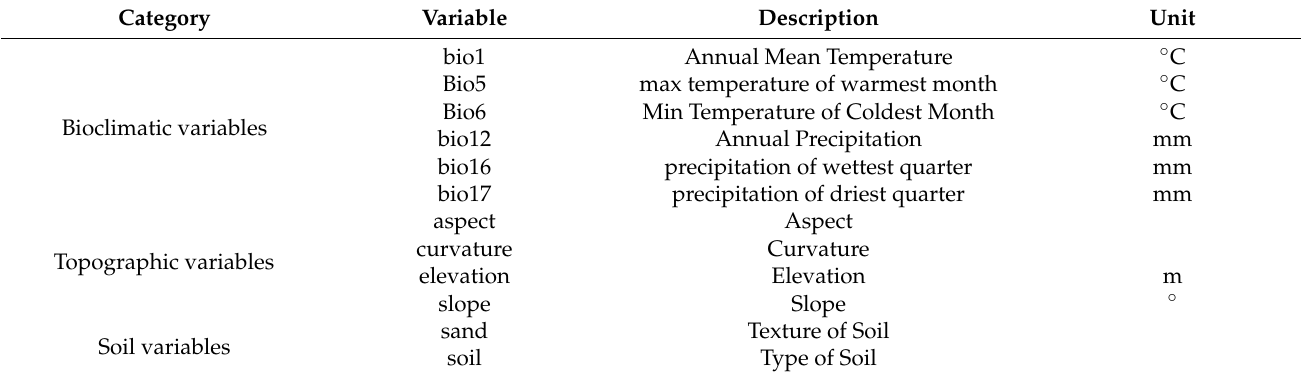
Table 1. Environmental variables used in predicting the potential distribution of Malus pumila Mill and Prunus armeniaca L. Category Variable Description Unit